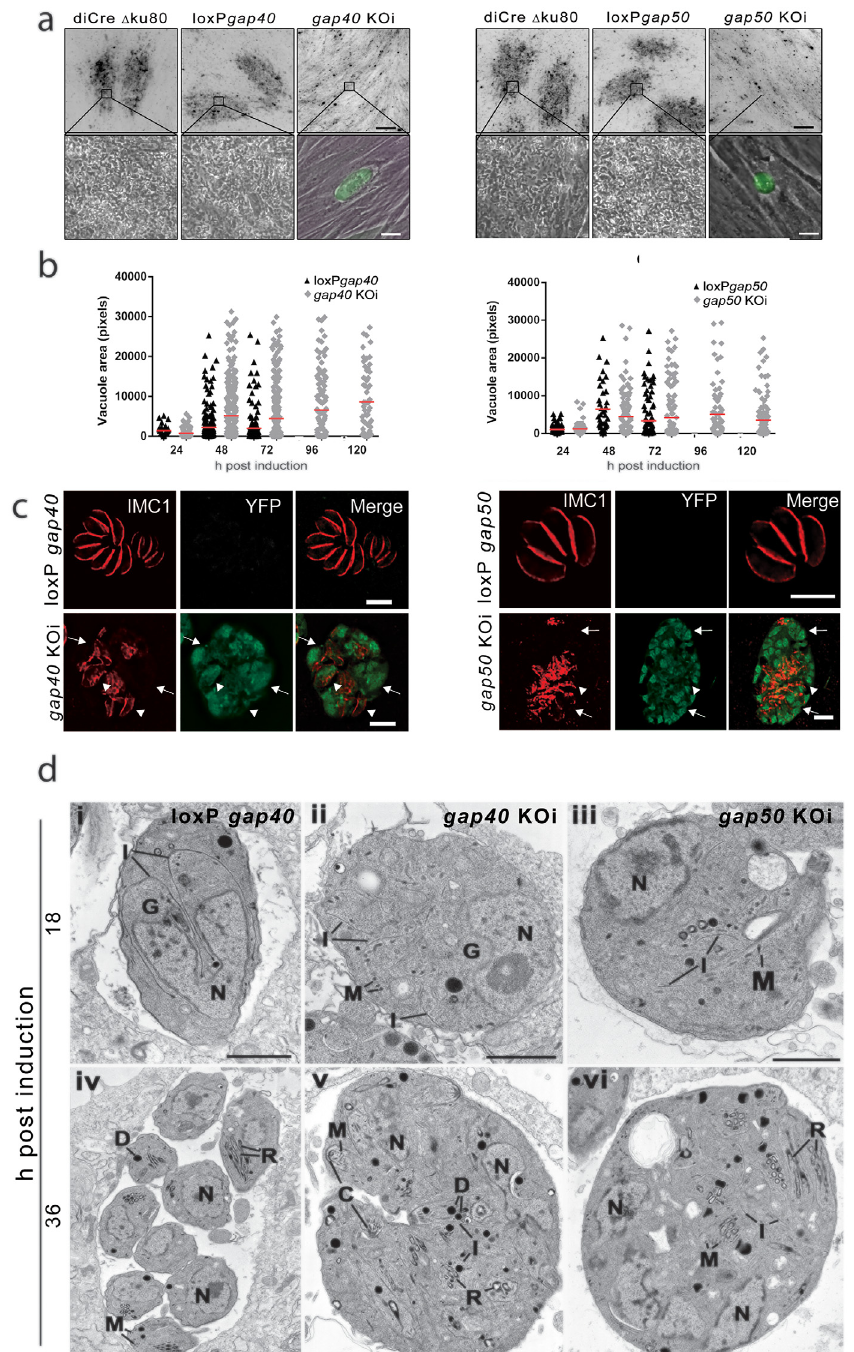
Fig 3. Conditional deletion of gap40 and gap50 leads to collapse of the IMC. ( a ) Growth assays of gap40 and gap50 KOi parasites. While control parasites showed normal growth behavior after 5 days of incubation, parasites lacking either gap40 or gap50 displayed no plaque formation on HFF monolayers. Scale bars represent 0.2 mm (upper panels) and 20 μ m (lower panels). ( b ) The area of vacuoles at various time points post induction was quantified. In loxP gap40 and loxP gap50 parasites, vacuole size increased up to 48 h before reducing due to egress and reinvasion. Both gap40 KOi and gap50 KOi vacuoles behaved in a similar manner to the controls up to 48 h. However, no parasite egress was seen and vacuoles within host cells were maintained for at least 120 h post induction. Each point represents one vacuole (black for loxP and gray